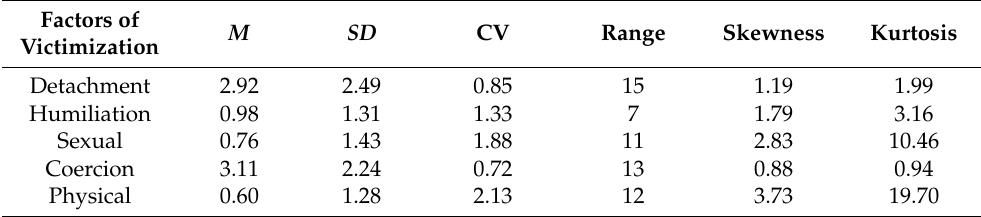
Table 1. Descriptive analysis of the victimization factors. Factors